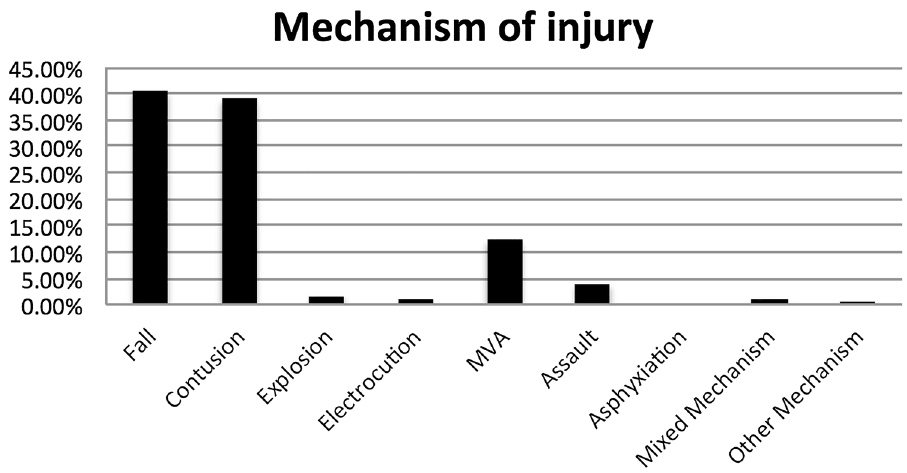
Figure 1. Mechanism of head injury (n = 244).